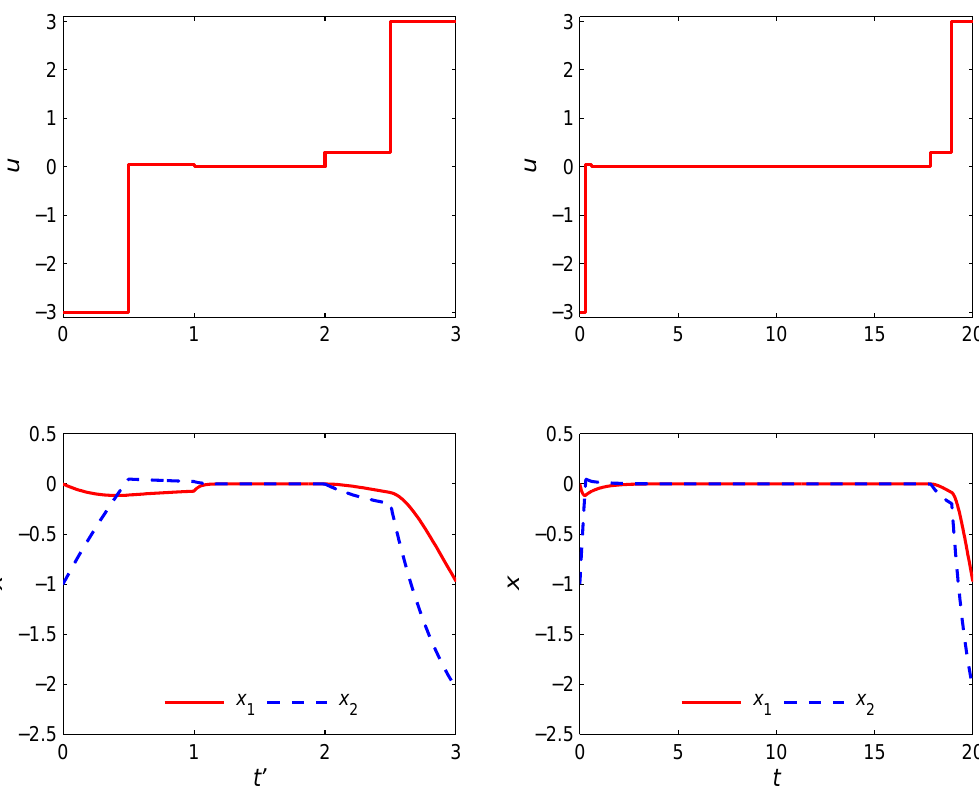
Figure 6. Optimal trajectories for Problem (37) in case of the proposed semi-uniform discretization approach with N = 5 epochs (both the main and variant formulations) in the t (cid:48) ( left ) and t ( right )